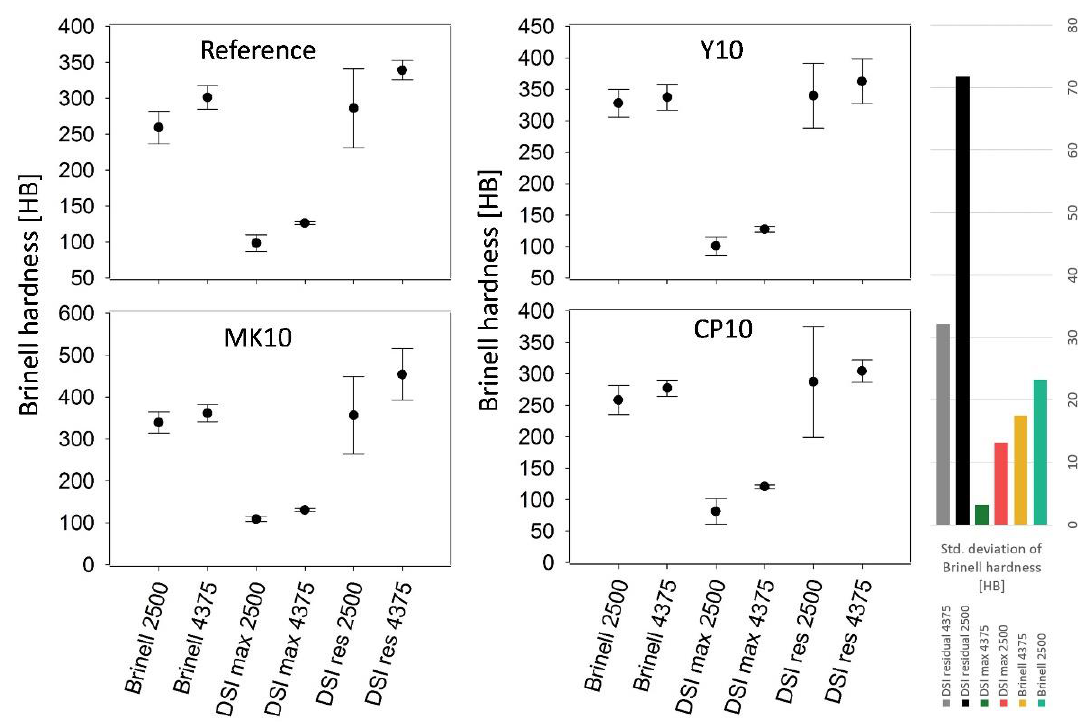
Figure 2. Mean values of Brinell hardness from the different measurement methods and their standard deviation.